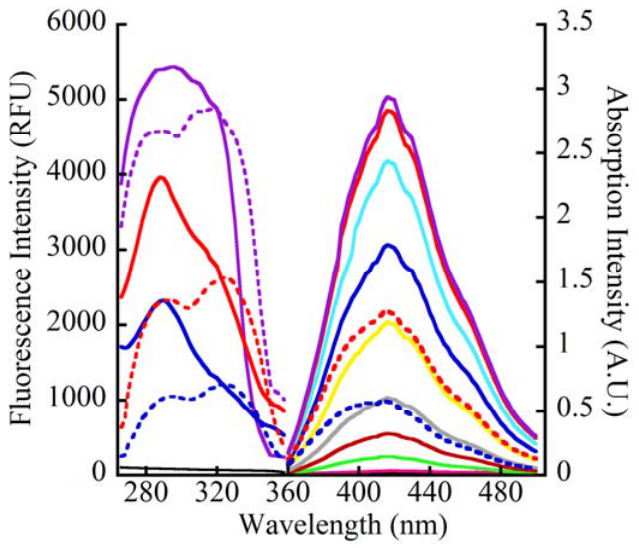
Figure 3. Absorption, excitation and emission spectra of CA. Left panel: Unmodified CA (100  L of 500  M CA in 100 mM NaOH) was dispensed into a 96-well UV-transparent microplate. Absorption was monitored between 250 to 350 nm in 2 nm intervals (solid tracings) for CA purchased from Alfa Aesar (blue), Acros Organics (red) and Sigma- Aldrich (purple). Excitation spectral profiles (broken tracings) were monitored between 250 to 350 nm in 2 nm intervals (emission = 420 nm) from CA purchased from Alfa Aesar (blue), Acros Organics (red) and Sigma-Aldrich (purple). The absorption and excitation profiles from 100 mM NaOH background are shown by the solid black tracing close to the abscissa. Right panel: The emission profiles of 100  L of CA in 100 mM NaOH ranged from 360 to 500 nm in 2 nm intervals with an excitation wavelength of 290 nm. Fluorescence emission with increasing intensities represented by the solid tracings were from the following concentrations (  M) of Sigma-Aldrich CA: 1.0 (magenta), 2.5 (green), 5 (maroon), 10 (grey), 25 (yellow), 50 (blue), 100 (aqua), 250 (red) and 500 (purple). The broken red and blue tracings represent the fluorescence emission from 500  M of CA from Acros Organics and Alfa Aesar, respectively. The black tracing close the abscissa is the background from 100 mM